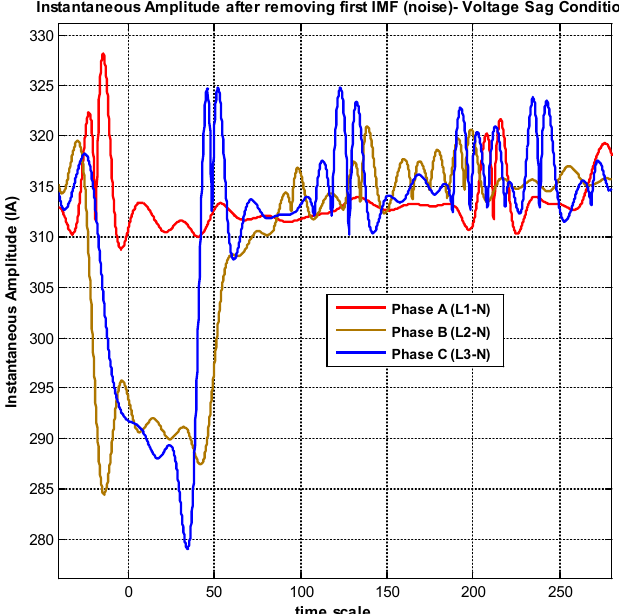
Fig. 11. IA corresponding to remove first imf voltage sag condition of signal The results show explicitly different pattern in Fig. 9.- normal condition as for Fig. 11. – voltage sag condition. Also it is clearly shown in fig. 11. voltage sag on two phases (L2- N, L3-N). This information will be used for evaluating active loads types and risk management of the grid.